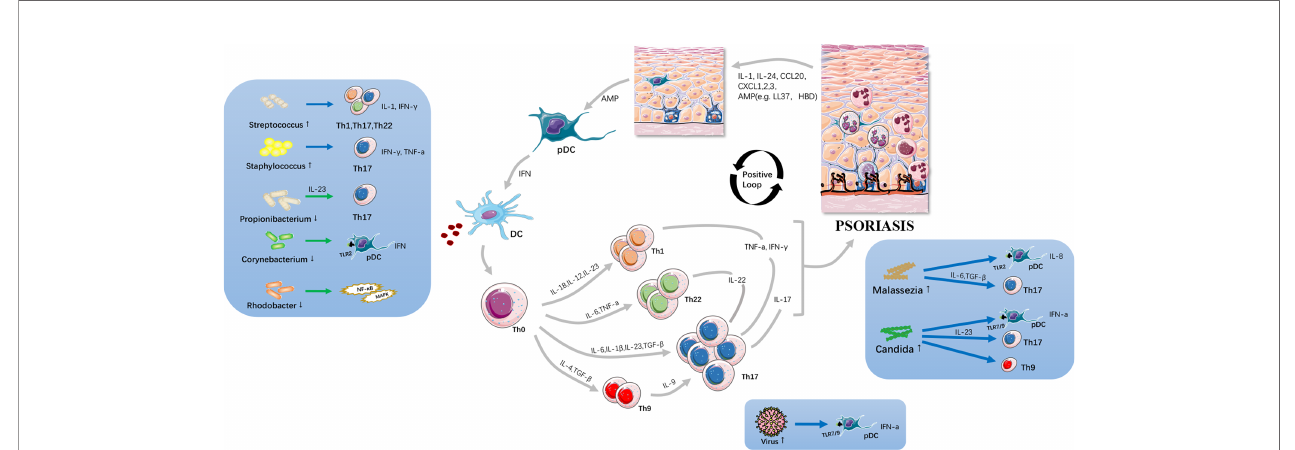
FIGURE 1 | Potential immunopathogenesis of psoriasis. The altered skin microbiota cause skin barrier disruption and act on innate immune system including Toll- like receptors etc.; and, subsequently drive Th17-associated in fl ammatory cascades. Large amounts of cytokines are secreted, resulting in immunocyte in fi ltration, angiogenesis and keratinocyte proliferation thus resulting in initiation and progression of psoriasis. Skin microbiota is viewed as a signi fi cant trigger and exacerbator in psoriatic in fl ammation